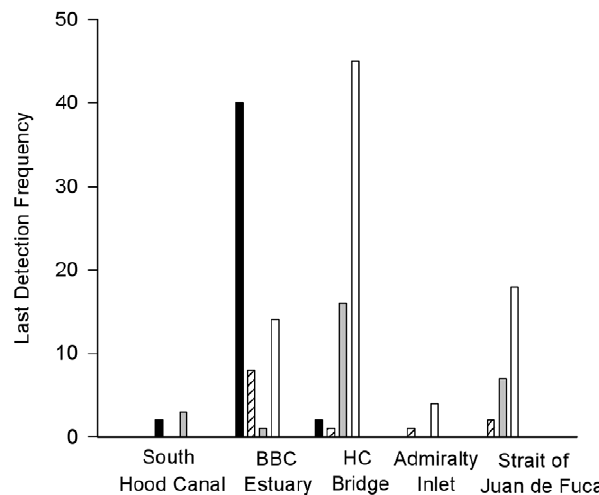
Figure 4. Numbers of cutthroat, steelhead, and hybrid smolts last detected at locations within the study area. South Hood Canal = . 20 km south of the Big Beef Creek estuary, Estuary = within 20 km of the Big Beef Creek estuary, HC Bridge = within 10 kilometers of the Hood Canal Bridge, Admiralty inlet =50 km from estuary, Strait of Juan de Fuca =150 km from estuary). Cutthroat ( 2 I H =0.0) are represented by black bars, phenotypic cutthroat hybrids ( 2 I H =0.270) by cross-hatched bars, phenotypic steelhead hybrids ( 2 I H =0.543) by gray bars, and steelhead ( 2 I H =1.0) by white bars.